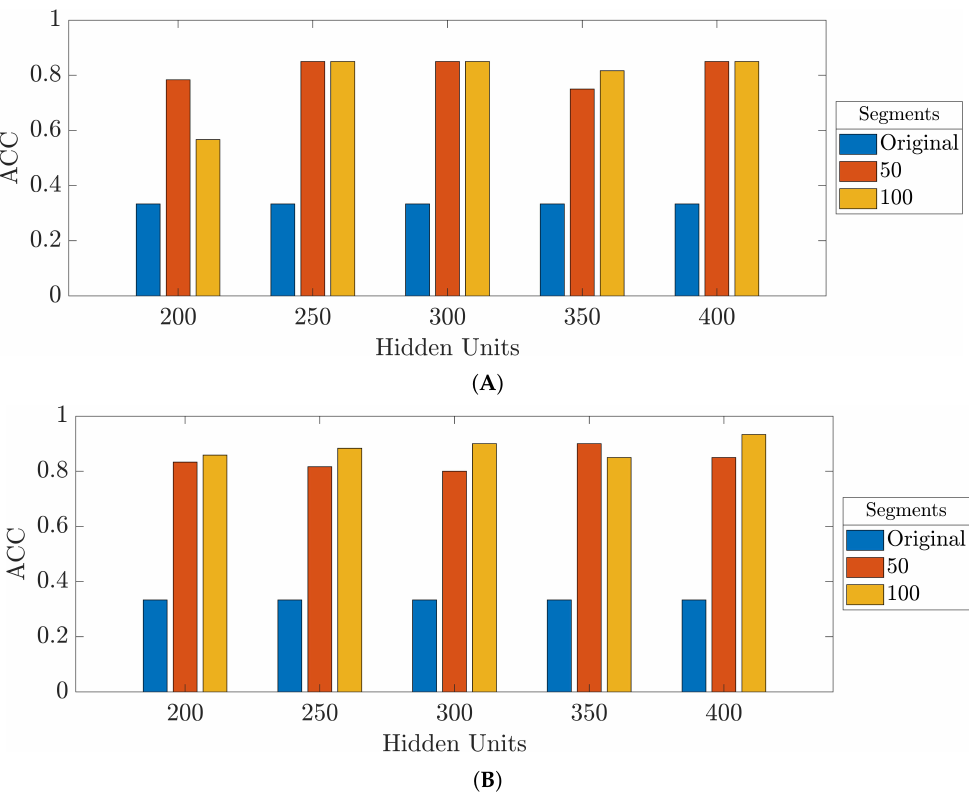
Figure 11. Accuracy of the test data from the networks trained with the 35-mer adenosine dataset and the ADAM optimizer: ( A ) ULSTM network; ( B ) BLSTM network.